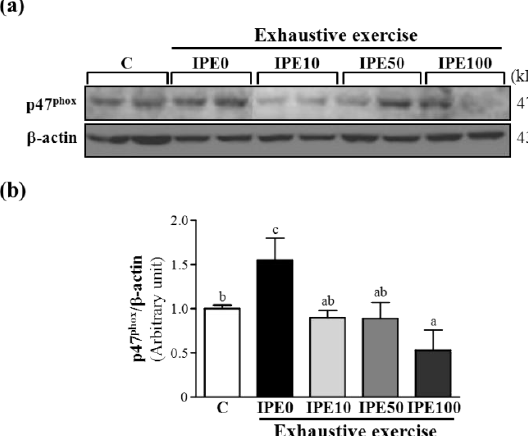
Data are presented as the mean ± SD. Different letters (a, b, c) indicate a significant difference at p <